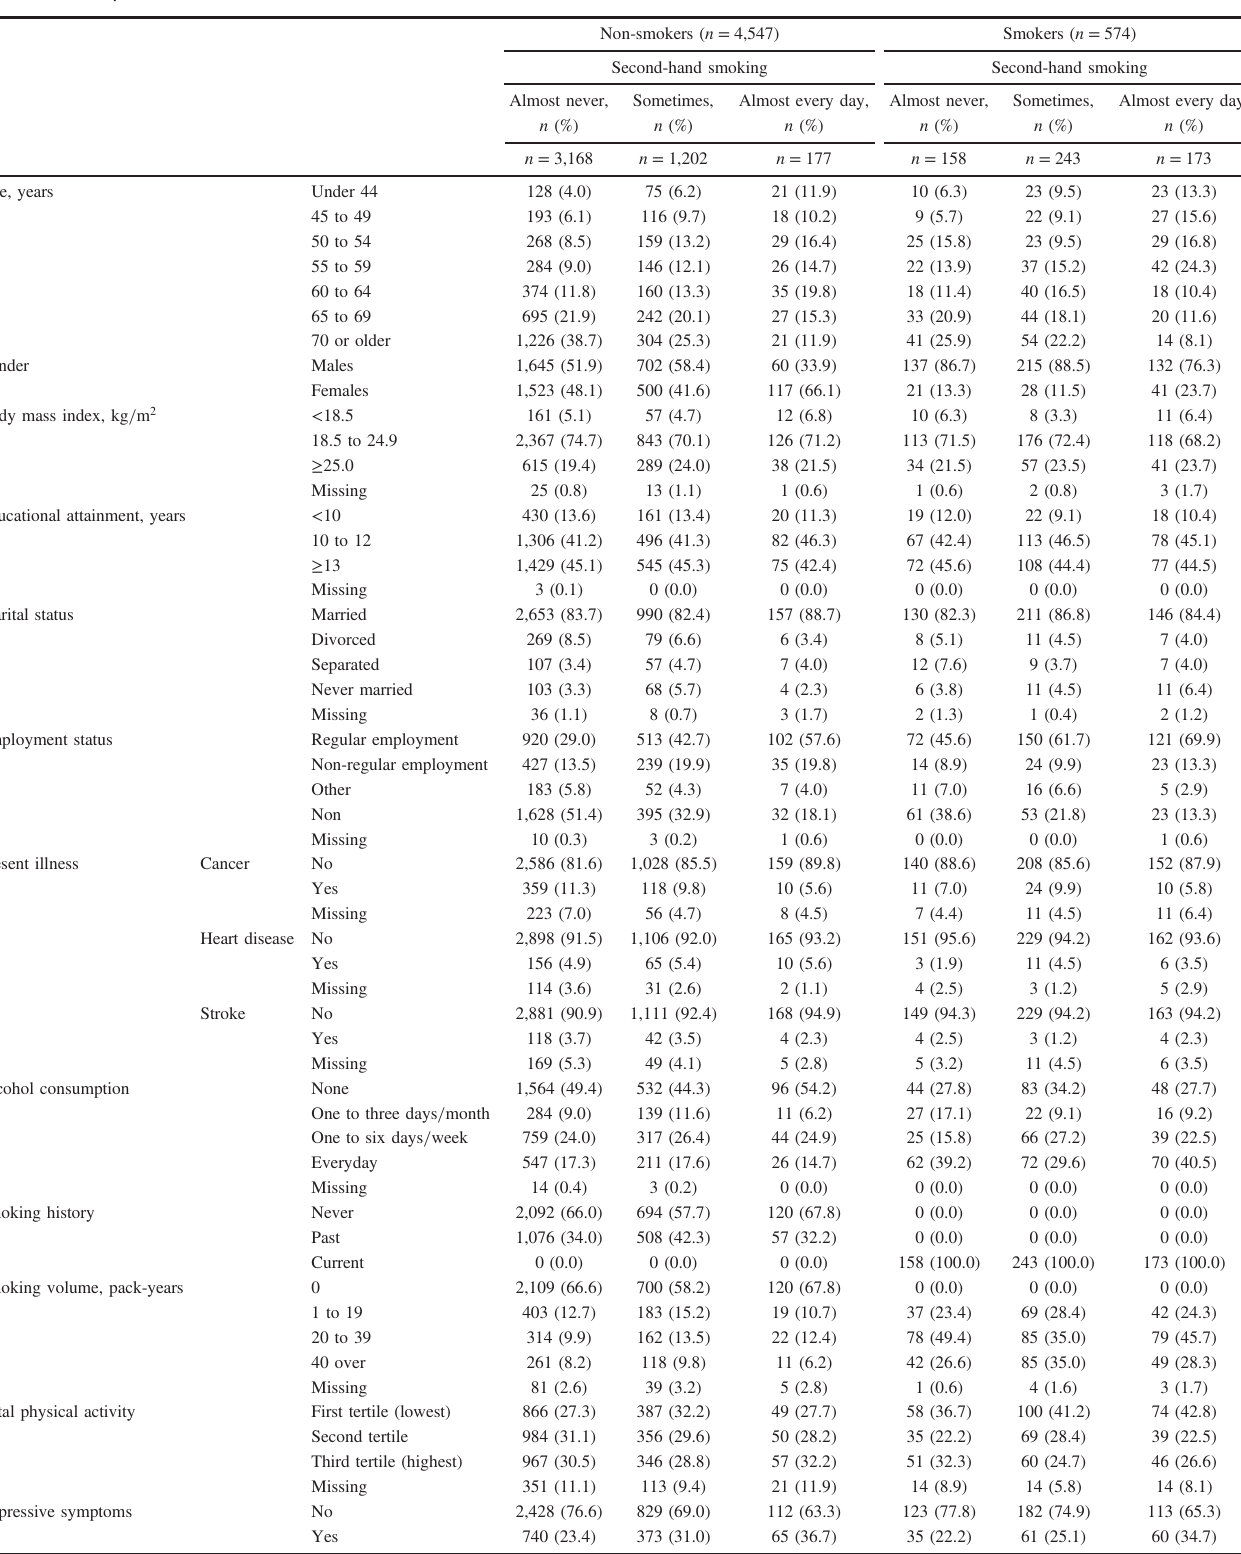
Table 1. Respondent